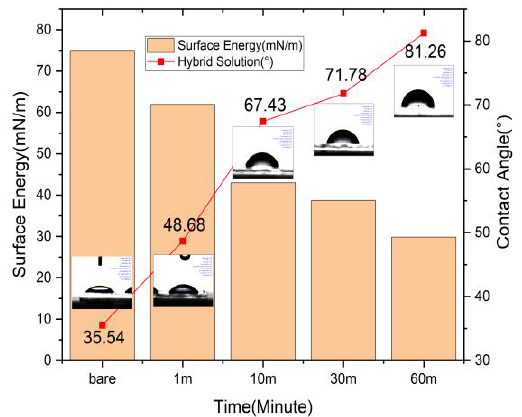
Figure 2. Hybrid solution–surface energy and contact angle.